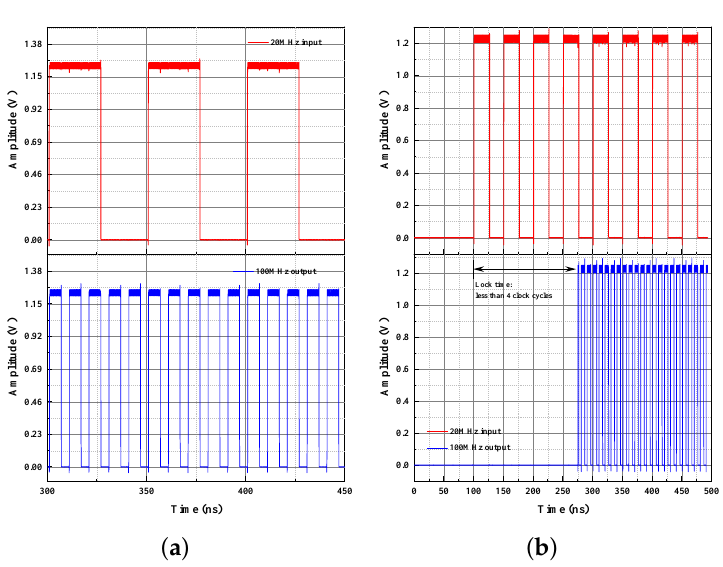
Figure 14. Simulation setup diagram of the proposed clock frequency multiplier.